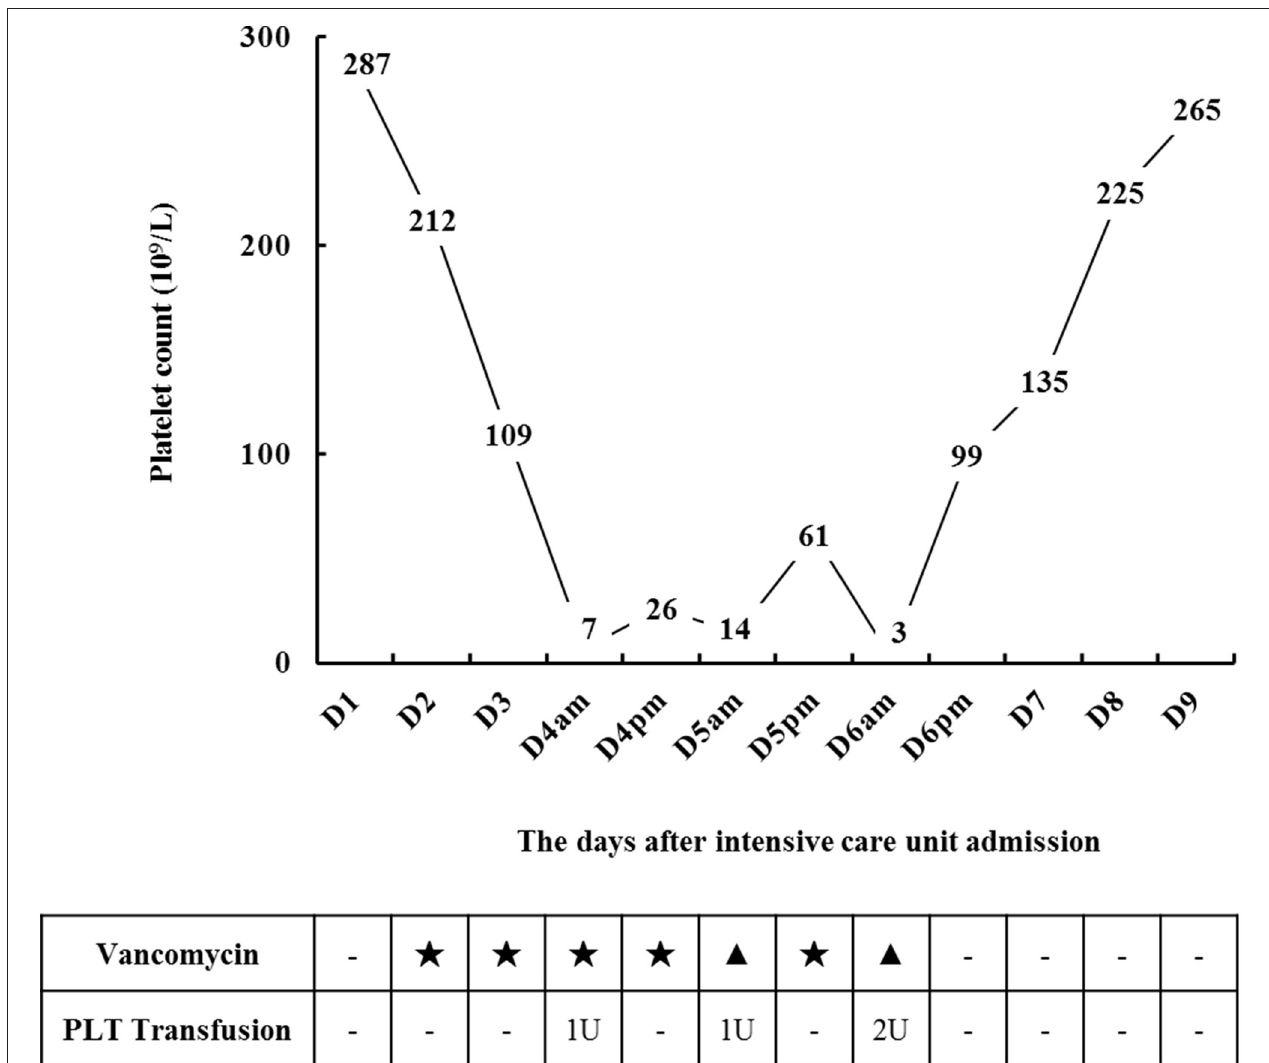
FIGURE 1 | Changes in platelets during treatment. ⋆ means vancomycin exposure, N means discontinuation of vancomycin. PLT, platelet; U, unit, 1U = 2.5 × 10 11